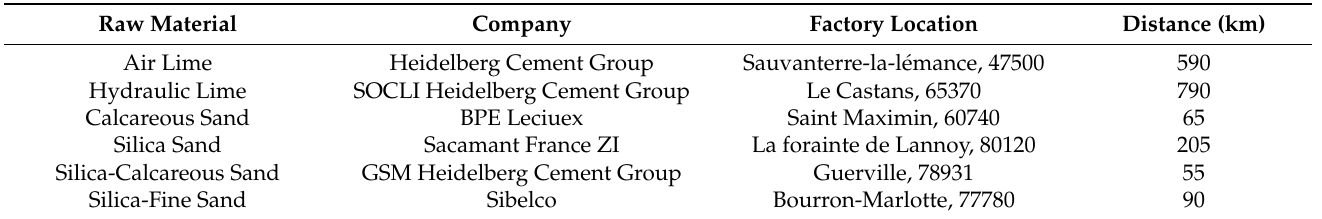
Table 7. Transport distance of raw materials to the Royal Palace located at 8, Rue de Montpensier, 75001 Paris.